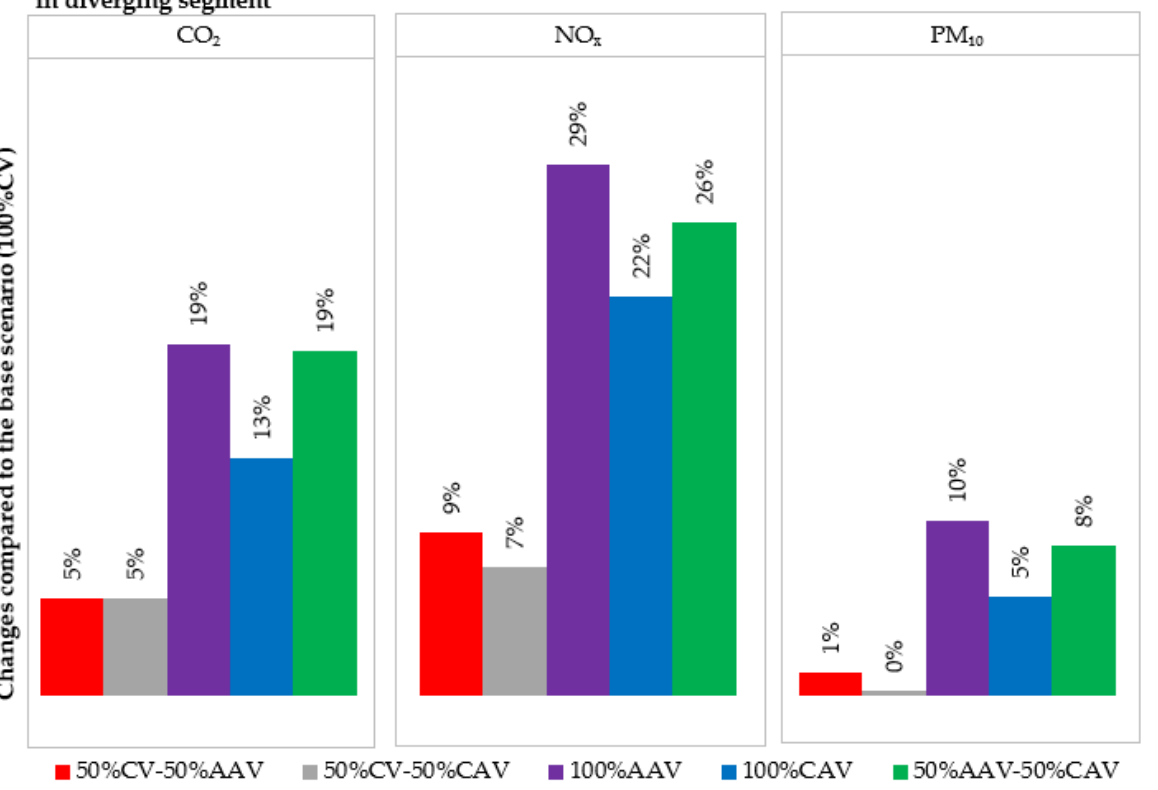
Figure 10. Simulation results of traffic emissions compared to the base scenario (100% CV): diverging segment.